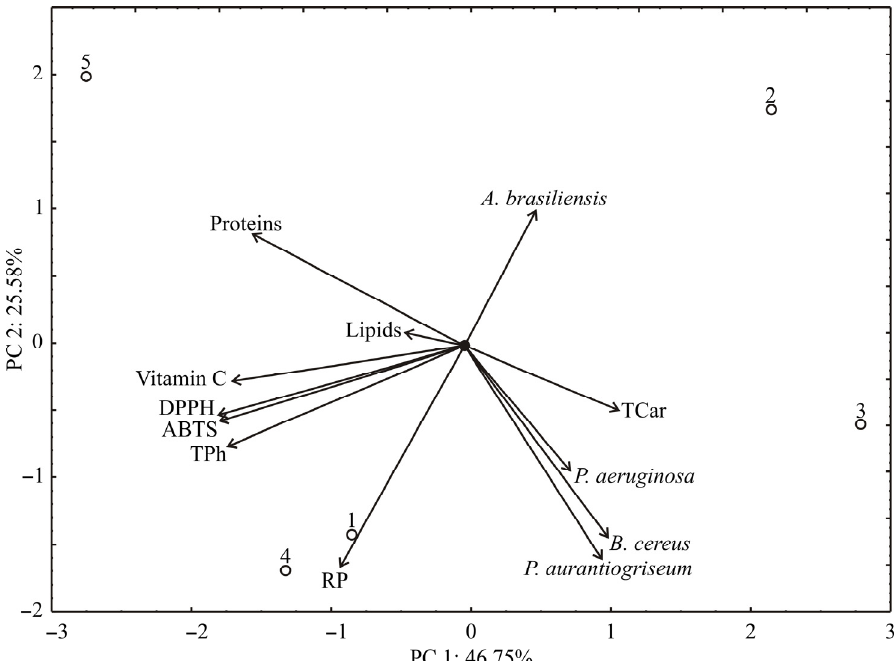
Figure 3. PCA ordination of variables based on correlations of peel samples .